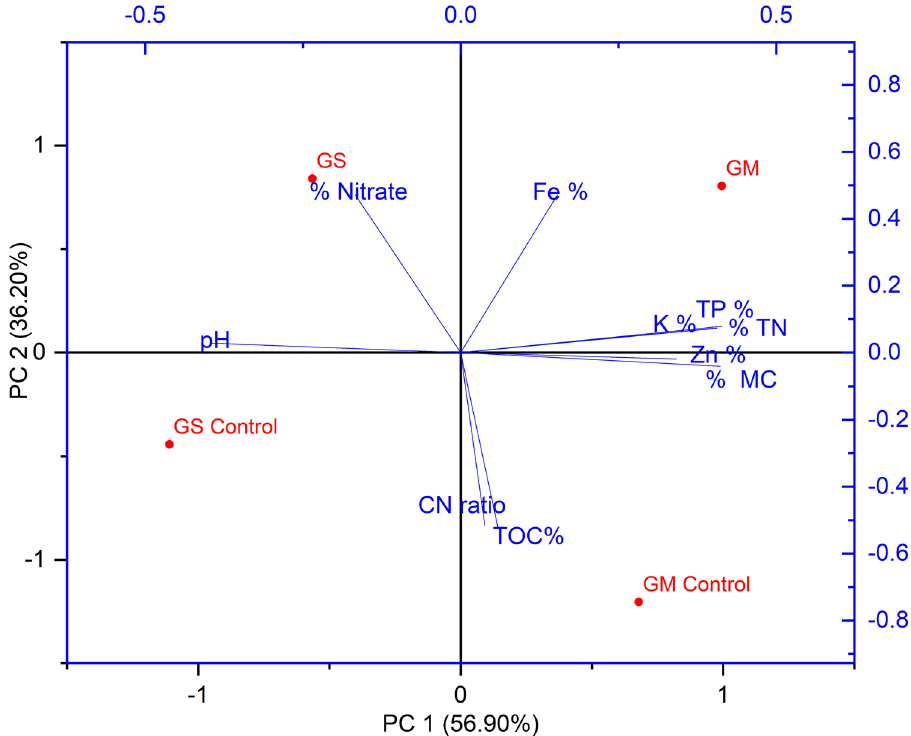
Figure 8. Principal component analysis of physico-chemical parameters in GS and GM coprolites compared to controls. The uninoculated treatments with A. caliginosa are referred to as the control.